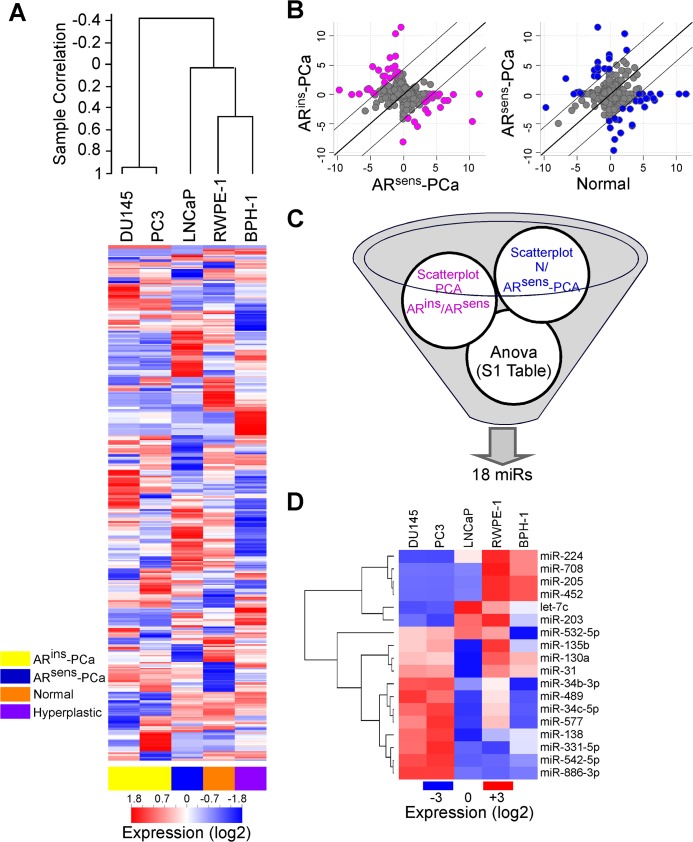
miRNA expression in prostate cell lines.
A) Heat-map of global miRNA profiles (≈750 miRNAs) in non-tumorigenic (RWPE-1, Normal), hyperplastic (BPH-1), androgen–dependent (LNCaP, ARsens-PCa) or–independent (DU145 and PC3, ARins-PCa) prostate cancer cells. Red, over-expression; blue, under-expression, respectively. B) Scatterplots diagrams were performed between androgen–dependent and–independent PCa cells and between normal prostate cells and ARsens PCa cells to select miRNAs with differential expression in either direction (fold-change) of at least 20 folds. A list of 41 miRNAs simultaneously altered in both comparisons was generated. C) Schematic diagram of selection criteria adopted to identify miRNAs potentially related to PCa. D) The eighteen miRNA signatures identified in C were verified by qPCR in the indicated prostate cells. All miRNAs except two (miR-577 and miR-886-3p) had mouse orthologs. Red, white and blue colors in the heat-map represent higher, equal or lower miRNA expression in samples respect to median miRNA value.